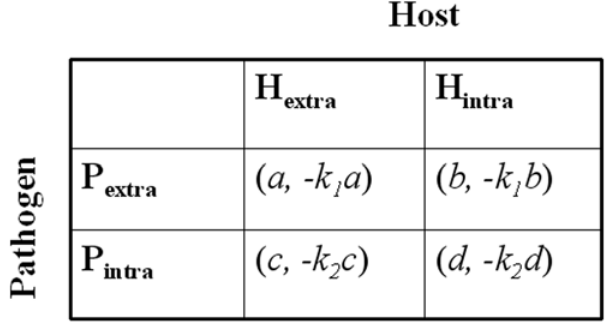
Figure 1. Payoff matrix of host-pathogen game. The game consists of two players- the host and the bacterial pathogen. P extra and P intra are the strategies of the bacterial pathogen to thrive inside the extracellular and intracellular compartments of the host, respectively. H extra and H intra are the strategies of the host to counteract the bacterial pathogen using extracellular and intracellular defense mechanisms, respectively. a , b , c and d are the payoffs of the bacterial pathogen during four possible pure strategy situations and 2 k 1 a , 2 k 1 b , 2 k 2 c and 2 k 2 d are the corresponding payoffs of the host. k 1 and k 2 are proportionality constants.